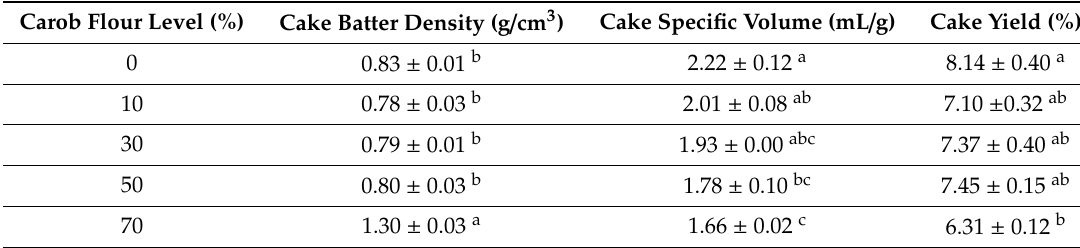
Table 2. Physical properties of batters and